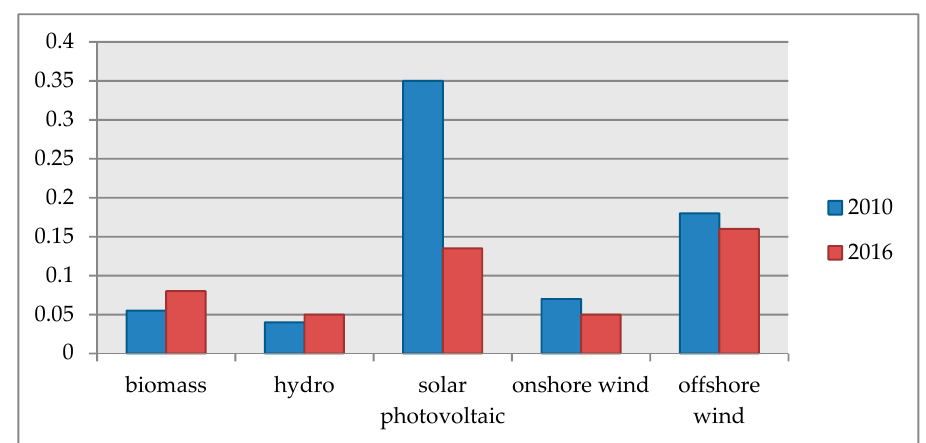
Figure 2. World wind and solar production capacity, GW.